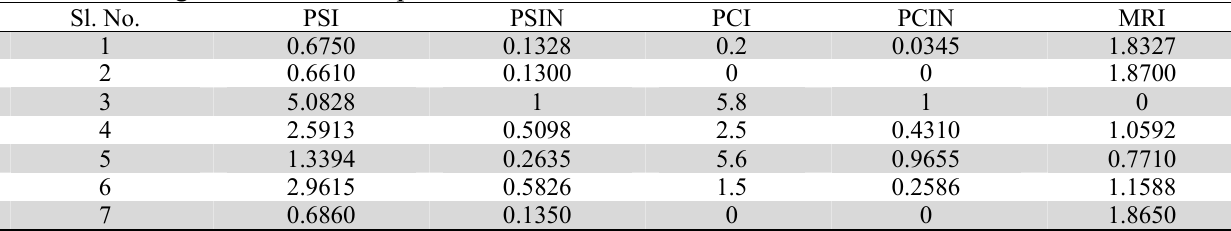
Material rating indices for example 2 Sl.